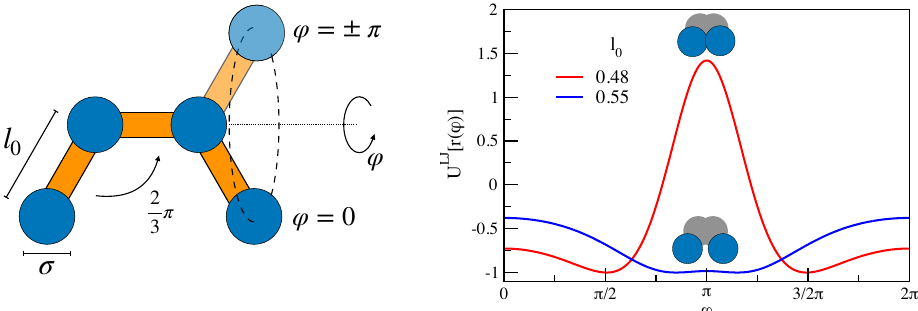
Figure 8. ( Left ) Schematic representation of a fragment of the polymeric chain model adopted in the MD simulations. For clarity reasons, the bond lengths are exaggerated. The dihedral angle ϕ is the angle by the two planes defined by the first and last three monomers of the fragment. ( Right ) Effective torsional potential resulting from the Lennard–Jones interaction between the first and the last monomers of the fragment. An abrupt change in the potential occurs by shortening the bond length l 0 from 0.55 σ to 0.48 σ with the appearance of a considerable energy barrier.